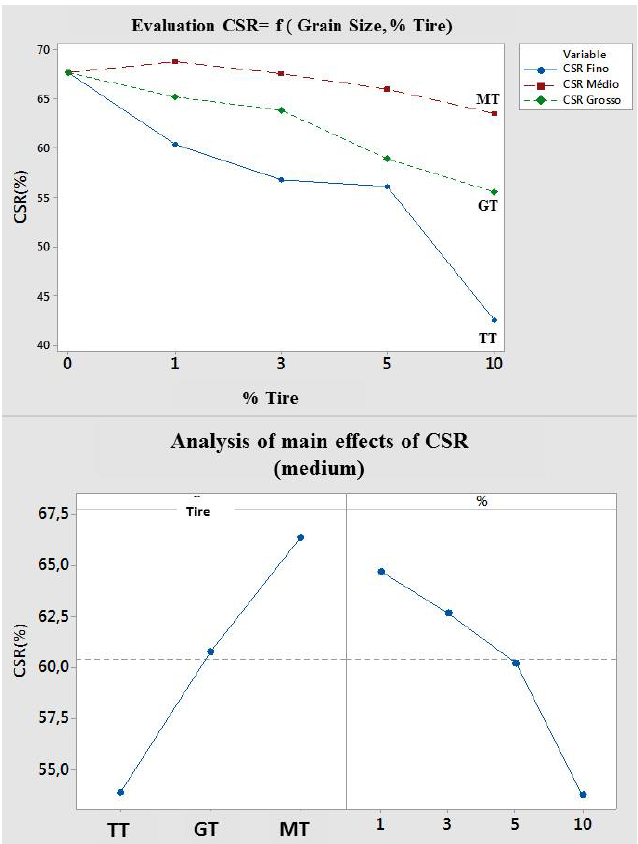
Figure 6. Variation of CSR coke regarding the percentages and types of tires.